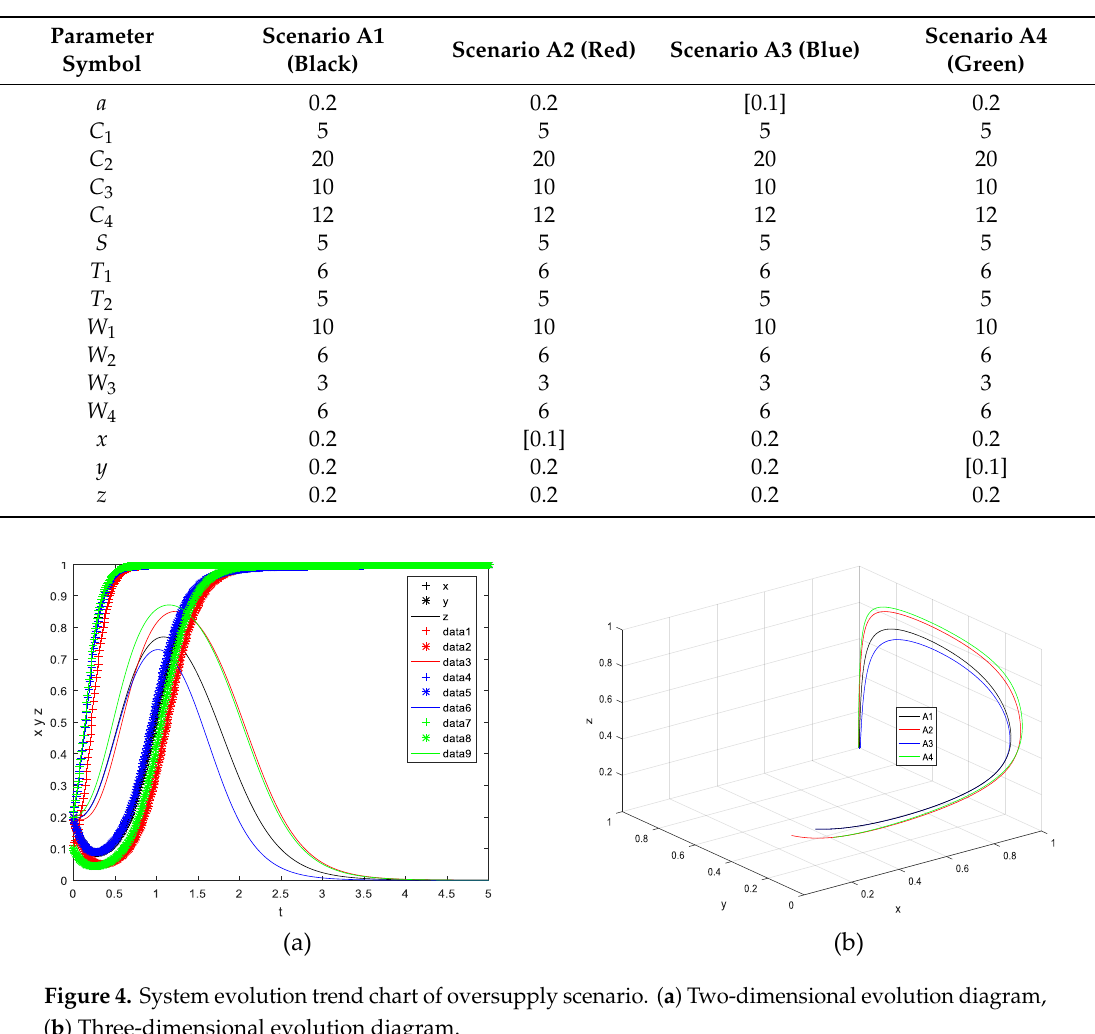
Table 4. Value of oversupply scenario.